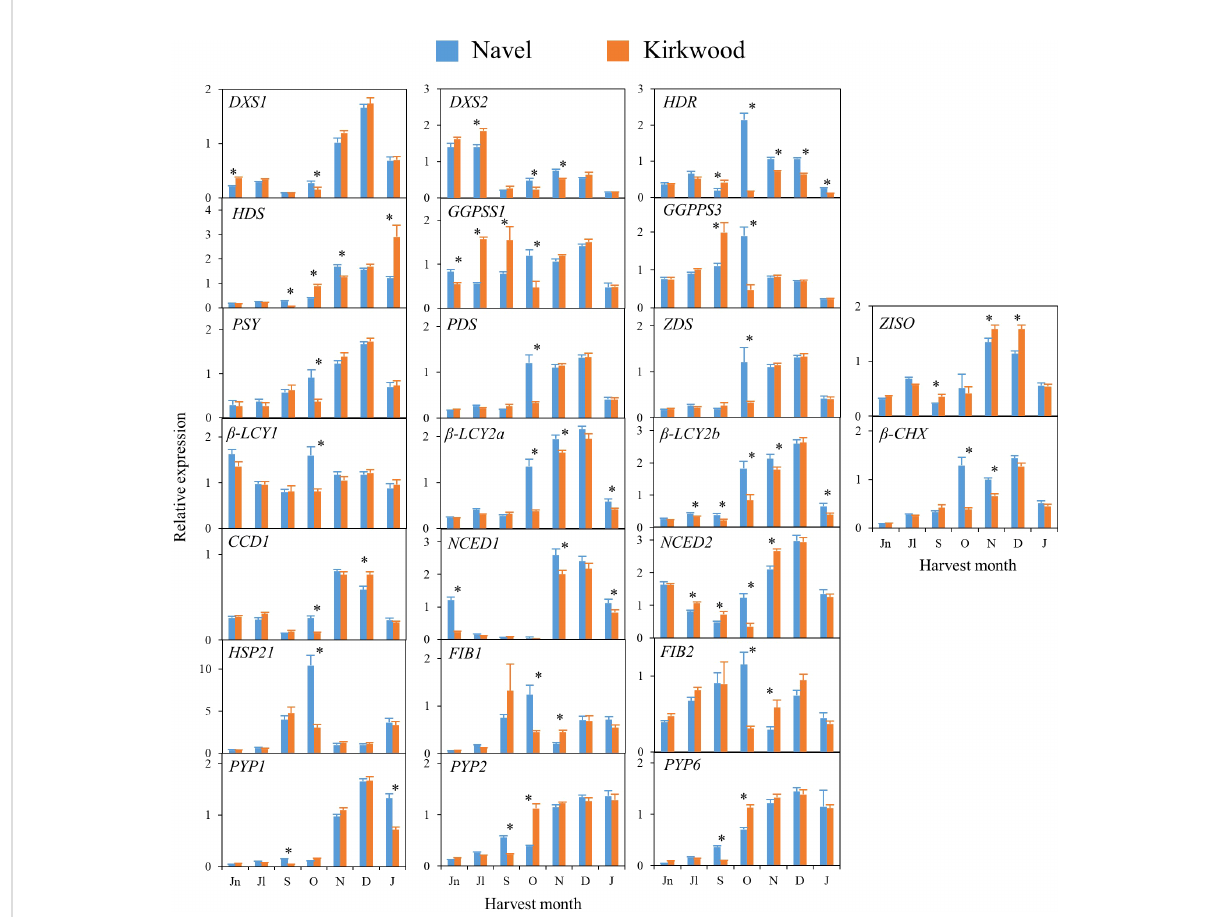
FIGURE 5 Relative expression levels of genes of carotenoids precursors ( DXS1 , DXS2 , HDR , HDS and GGPPS1 and GGPPS3 ), carotenes and xanthophylls biosynthesis ( PSY, PDS, Z-ISO, ZDS, b -LCY1 , b -LCY2a , b -LCY2b , b -CHX ), carotenoids catabolism ( CCD1b ), ABA biosynthesis ( NCED1 and NCED2 ), carotenoid-associated protein ( HSP21 , FIB1 and FIB2 ) and xanthophyll esteri fi cation ( PYP1, 2 and 6 ) in the pulp of Navel and Kirkwood during fruit development and maturation. Jn, June; Jl, July; S, September; O, October; N, November; D, December; J, January. Data are the mean of three biological replicates ± SD. Asterisks indicate signi fi cant differences between Navel and Kirkwood varieties by unpaired Student ’ s t- test (p <